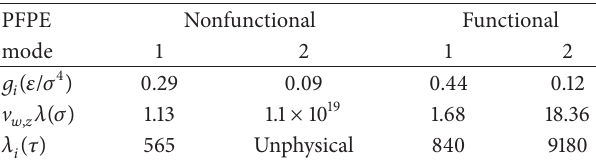
Table 8: The elastic moduli and relaxation times for the 𝑁 -modes (𝑁 = 2) Maxwell model for both nonfunctional and functional PFPE